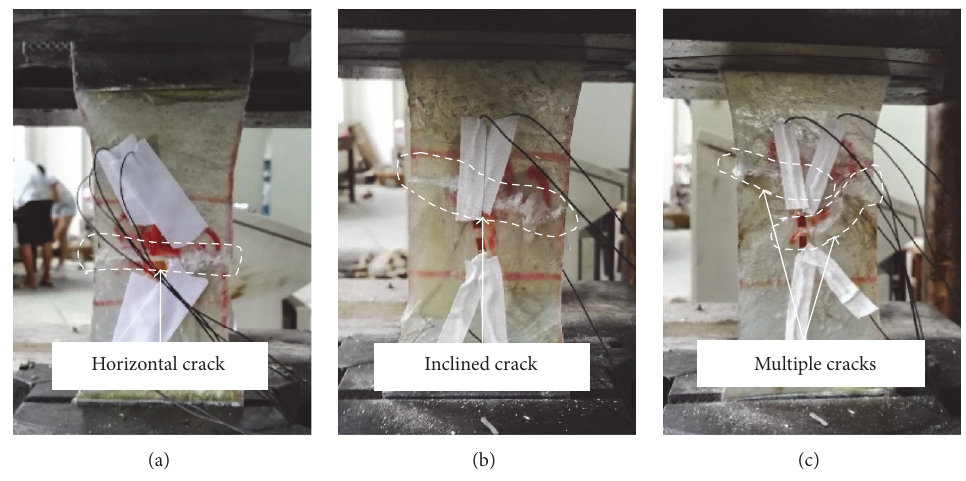
Figure 10: Failure modes of through